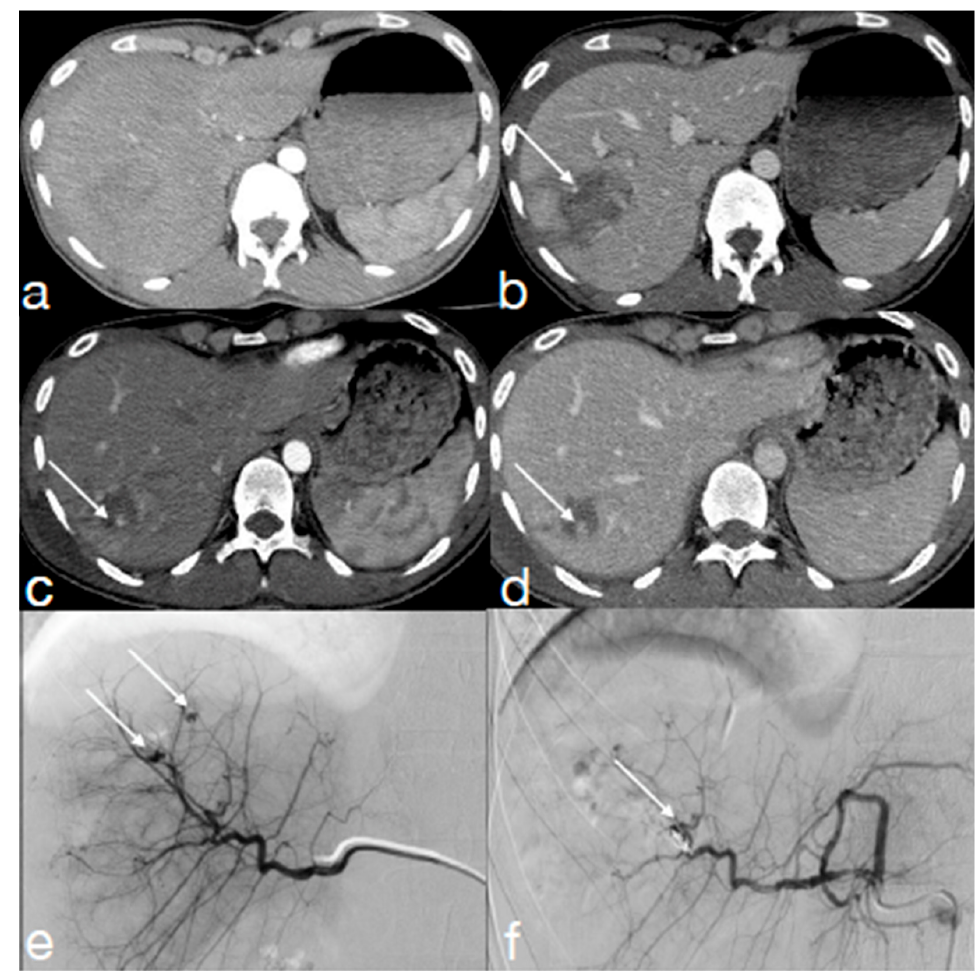
Figure 5. A forty-four-year-old male patient underwent high-energy blunt trauma. Enhanced CT upon admission (( a ) arterial phase; ( b ) venous-portal phase, axial plane) shows a large liver laceration with intraparenchymal hematoma (AAST III), with a small focus of hyperdensity initially seen in the portal phase (( b ) arrow) suspected for contained vascular injury. At the follow-up CT, which was performed 24 h later, another focus of hyperdensity suspected for pseudoaneurysm become evident (( c ) arterial phase; ( d ), venous-portal phase, arrows). Findings were confirmed at the following angiography (( e ) arrows) and successfully embolized (( f ) arrow, coils). The enhanced CT is the imaging method of choice to follow-up, in short time, about 24 h, those patients with suspected vessel injury or with low-grade vessel injuries treated conservatively